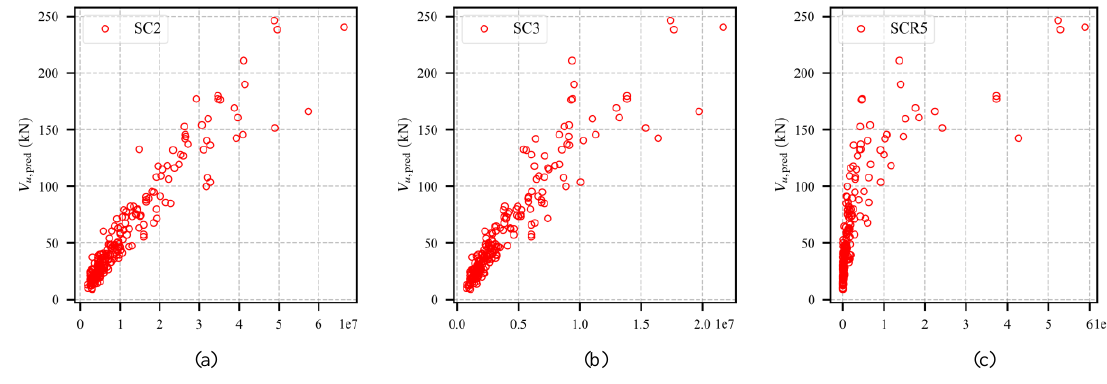
Figure 8. Data scatter of added features: ( a ) SC2; ( b ) SC3 and ( c ) SCR5.